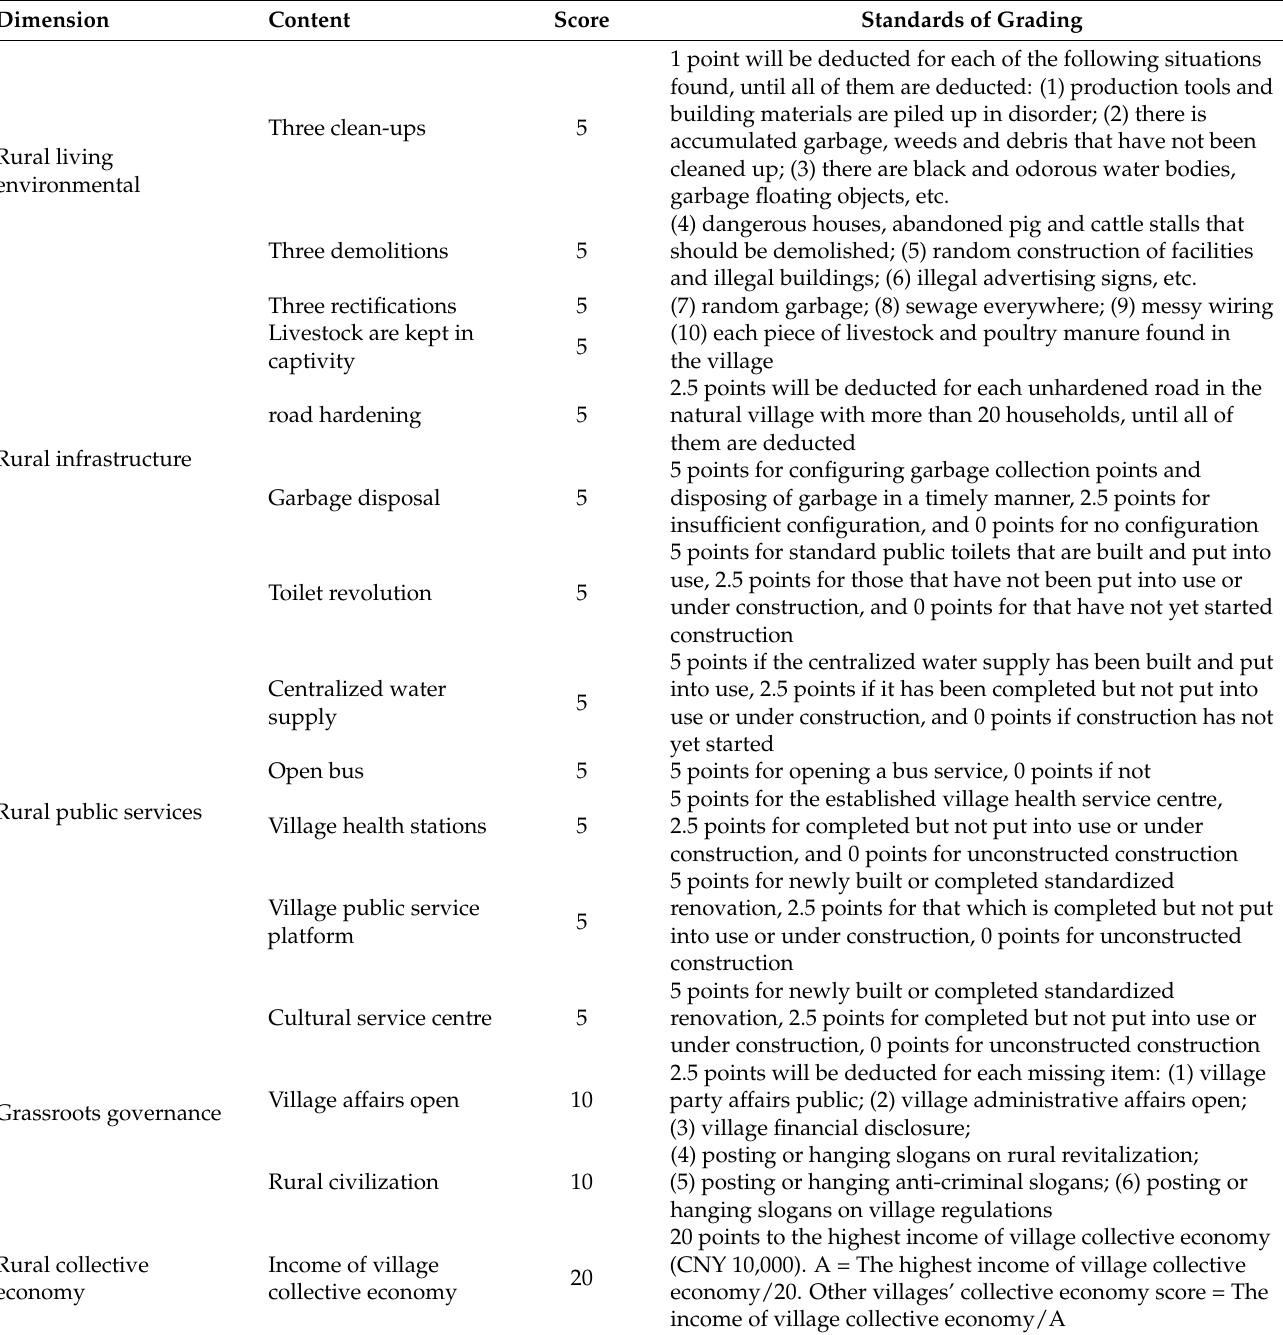
Table 1. An evaluation system for the implementation effect of SRD